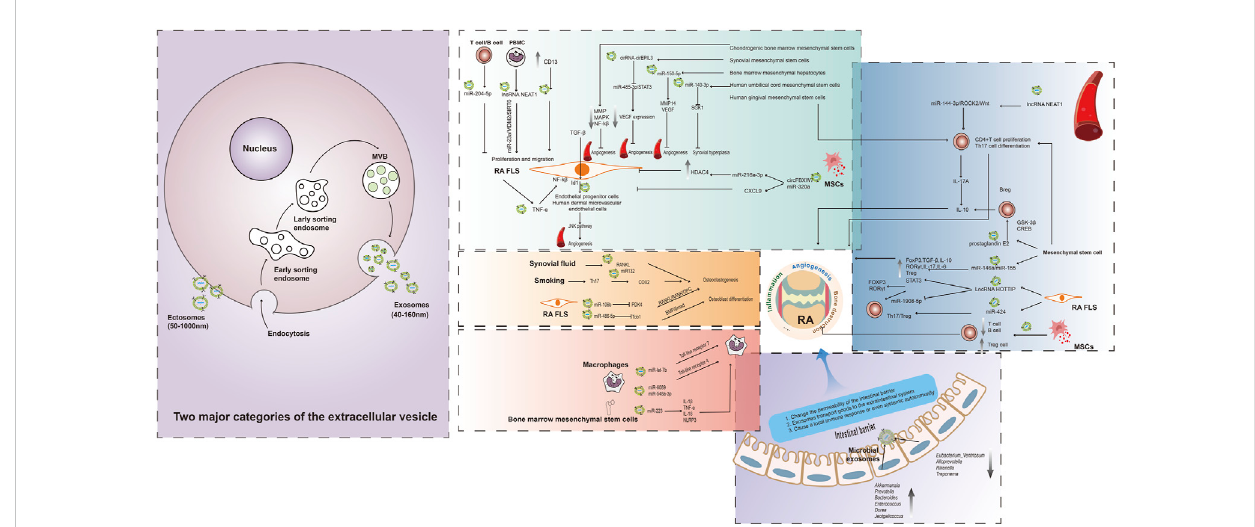
FIGURE 1 Association of multiple exosomes with RA. The extracellular vesicle can primarily be classi fi ed into two major categories, namely, ectosomes and exosomes. Ectosomes represent vesicles that result from the direct outward protrusion of the plasma membrane, generating entities such as microvesicles,microparticles, andlargevesicleswith sizes. Theproduction ofexosomes involves adoubleinvaginationoftheplasmamembraneandthe creation of intracellular multivesicular bodies (MVBs) containing intraluminal vesicles (ILVs). The ILVs are eventually released as exosomes through theprocessofMVBfusionwiththeplasmamembraneandsubsequentexocytosis.Blood,FLS,mesenchymalstemcells,andothercell-derivedexosomes are all associated with RA throughdifferentmechanisms. Gutmicrobe-derivedexosomes aremainly involved in alteringthe permeability ofthe intestinal barrier and transporting cargo to the extraintestinal system affecting the immune system, and may be a novel target for future RA